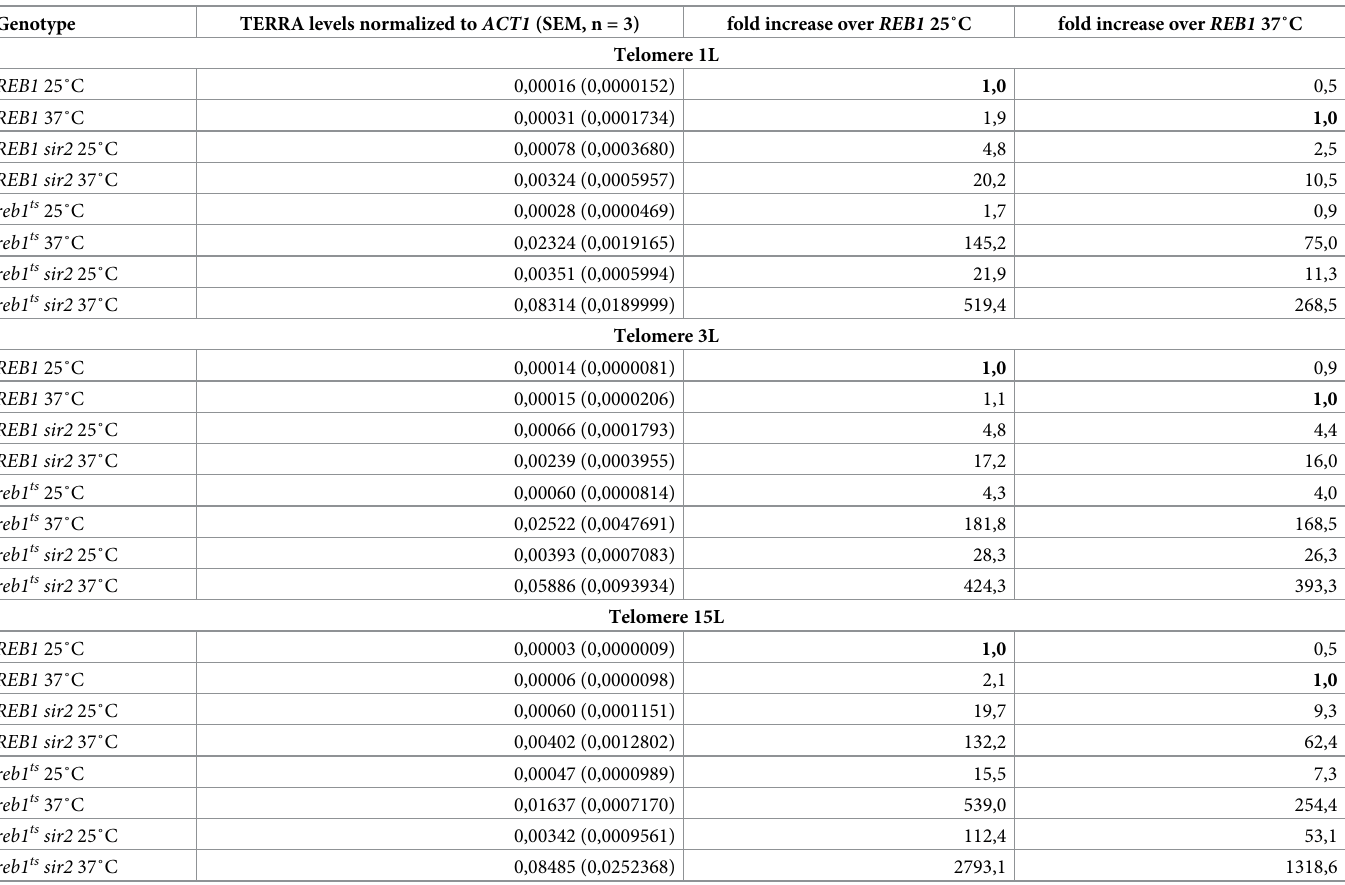
Table 1. TERRA levels are regulated by Sir2 and Reb1. Genotype TERRA levels normalized to ACT1 (SEM, n =